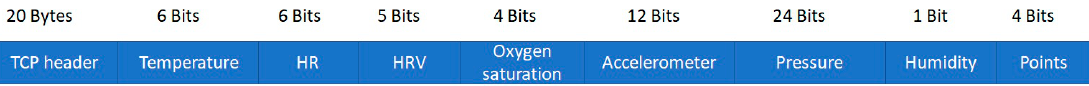
Figure 5. Message format of our system.